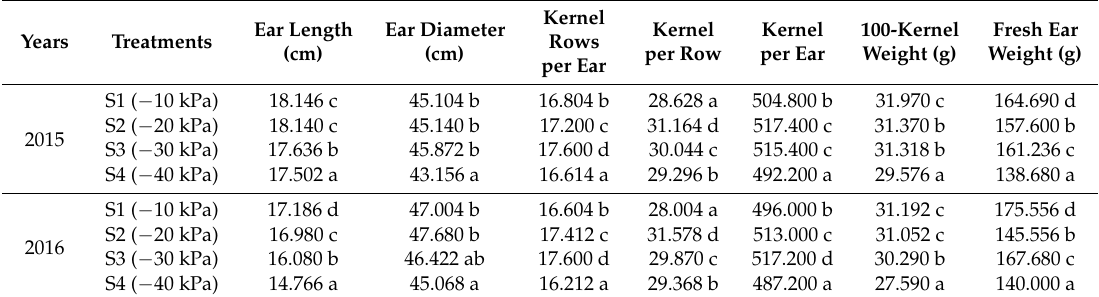
Table 7. The yield characteristics for treatments in 2015 and Table 7 . The yield characteristics for treatments in 2015 and 2016.